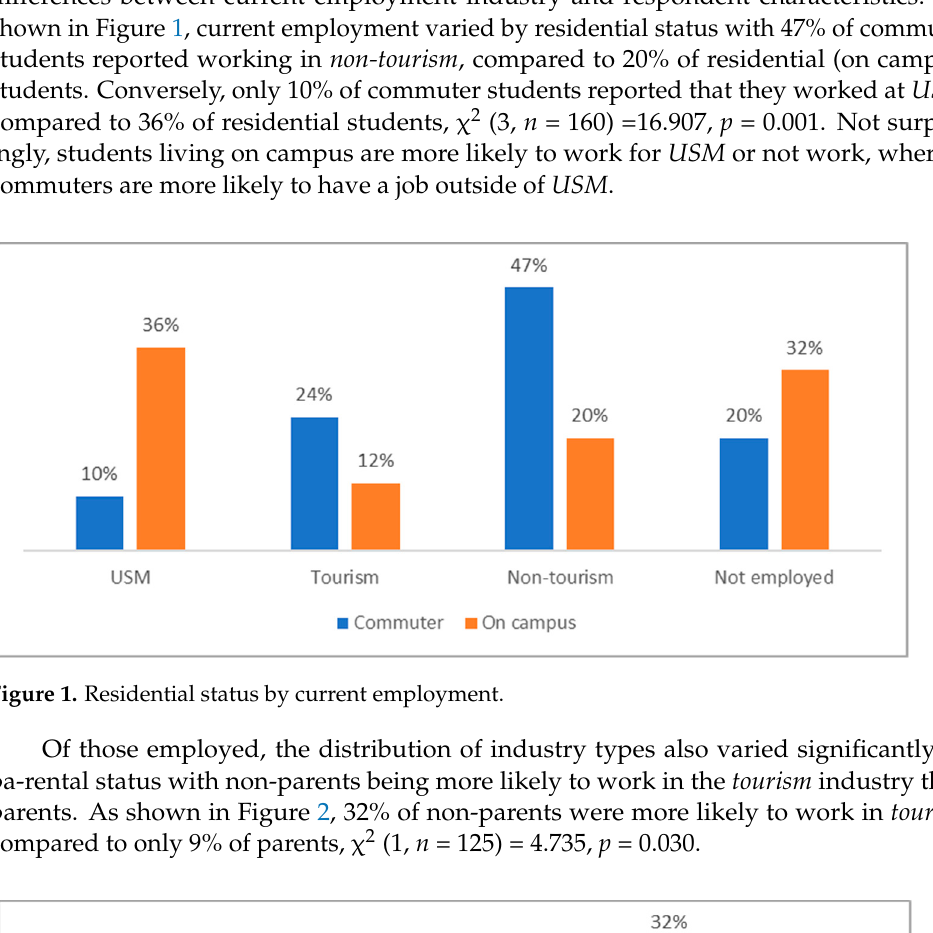
Figure 3. Pre-COVID impact on employment ( n = 133). In their open-ended responses, three students expressed difficulties finding jobs. One student “applied everywhere all first and second semester with no luck and very little money”, another student decided to pursue a master’s degree for stability with a concern for future jobs, and the third student stated, “There was nobody hiring for jobs that I was qualified for because so many businesses had shut down.” Furthermore, one student men- tioned COVID-related financial stress and three others mentioned mental stress. These statements from students complement survey results that COVID-19 created significant financial difficulties and mental stress. However, there were a few students who identified COVID-19 as an opportunity. One student reported replacing a job at which they were overworked and undercompensated with a job that paid more. Another student reported enjoying working from home but stated a desire to be in the office at least two or three days a week once COVID-19 ended. 4.4. Movement between Industries Because the survey asked students to report data from two points in time, it was possible to track respondents’ movement between industries (Figure 4). The majority, 72%, remained in the same category, whether they were in tourism , non-tourism , or unem- ployed . Smaller proportions, 13% moved into unemployment ; 9% into non-tourism ; and 6% into tourism jobs . Thus, most remained in the same industry, and the biggest movement